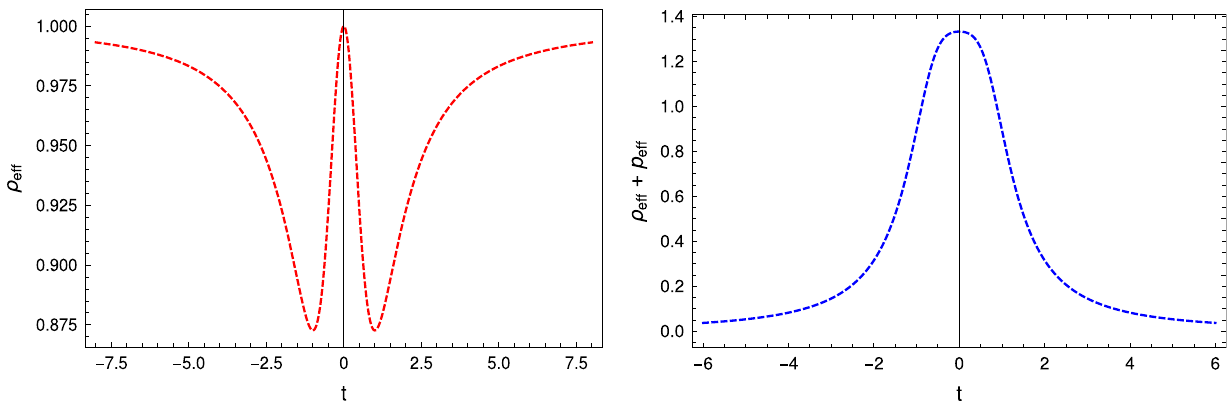
Fig. 3 Lef t part : ρ eff /ρ c vs. t for the weak energy condition. Right part : ρ eff + p eff vs. t for the null energy condition. In both cases, we take k γ = 1, a 0 = 1 (in reduced Planck units) and n = 1 /